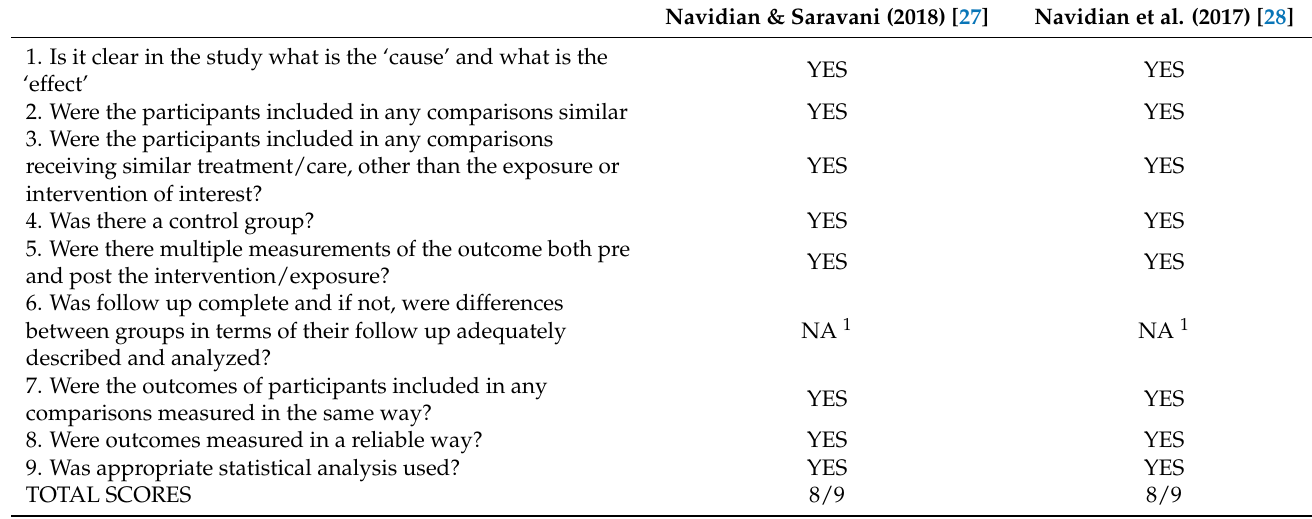
Table 1. Analysis of quasi-experimental studies with the JBI Checklist [26].